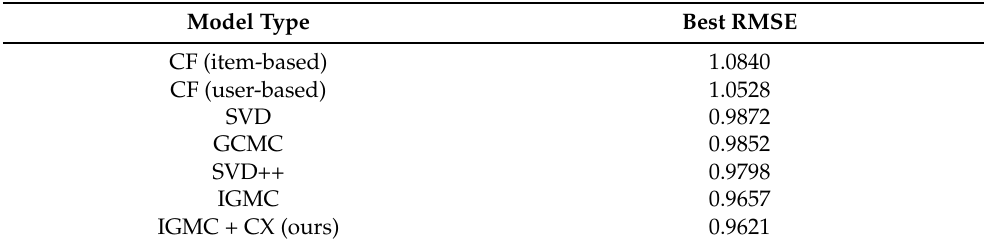
Table 2. RMSE Table of Amazon movie data.